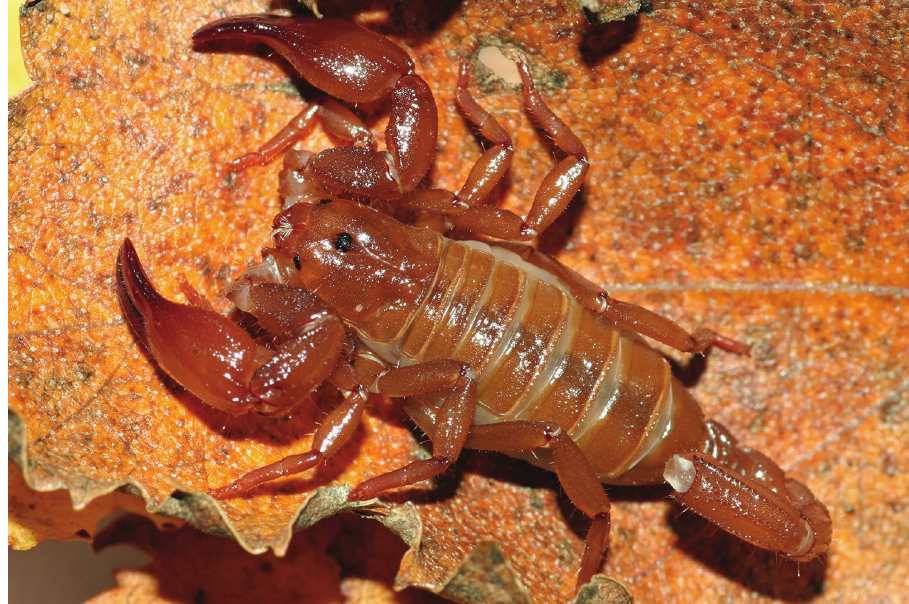
Figure 25. Guyanochactas flavus , female paratype from Anamites. Guyanochactas gonzalezspongai (Lourenço, 1983) Fig.